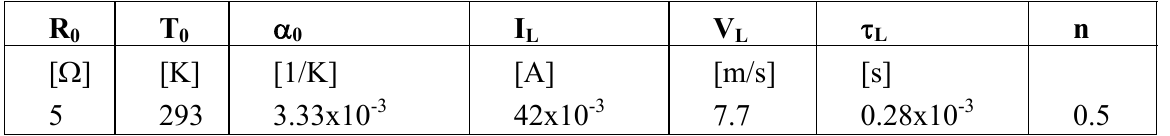
Table 1. Parameters of the simulated measuring sensor.